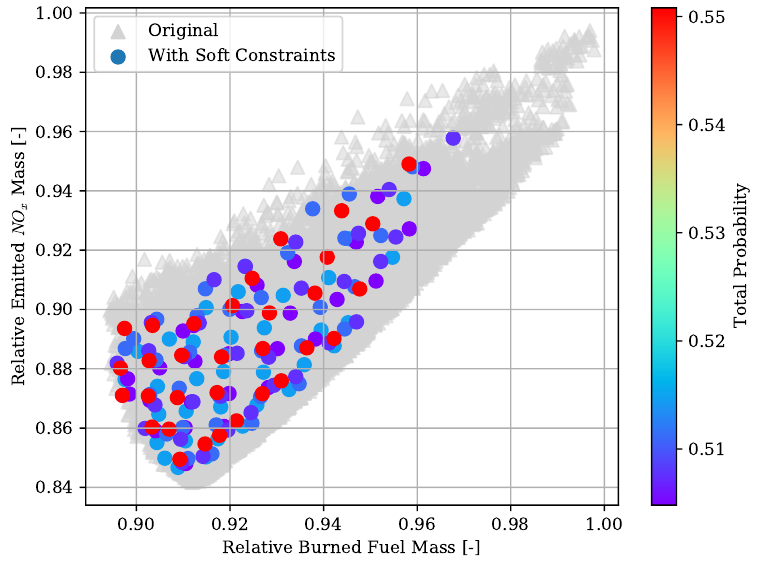
Figure 7. Data of Experiment CC-2S with additional soft constraints.